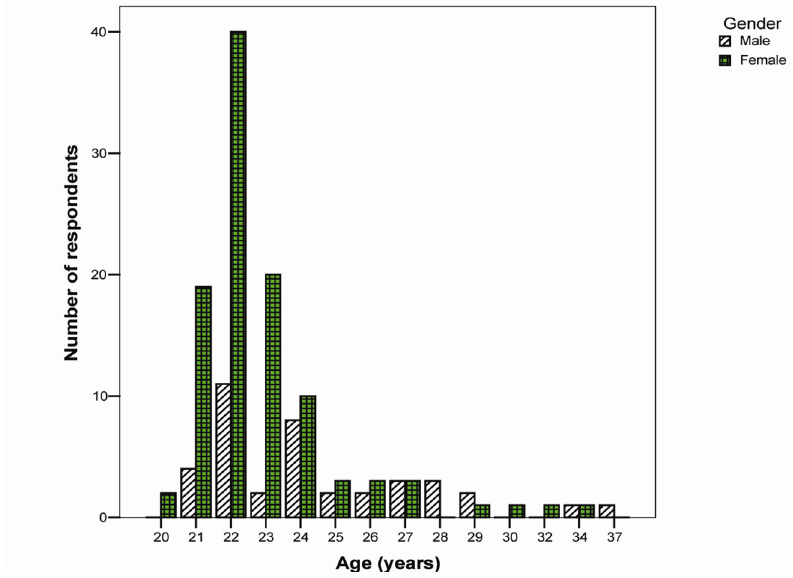
Figure 1: Showing the ages of the respondents in relation to their gender. The ages ranged from 21 to 37 years for males and 20 to 34 years for females. The most common age was 22 years for both males and females.